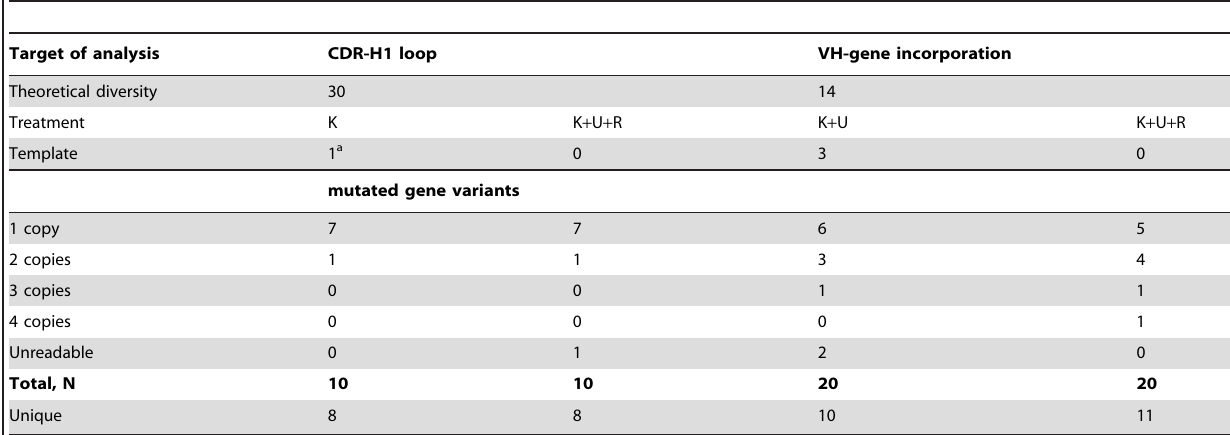
Table 1. Diversity based on sequencing in CDR-H1 loop mutagenesis and VH-gene incorporation experiments.